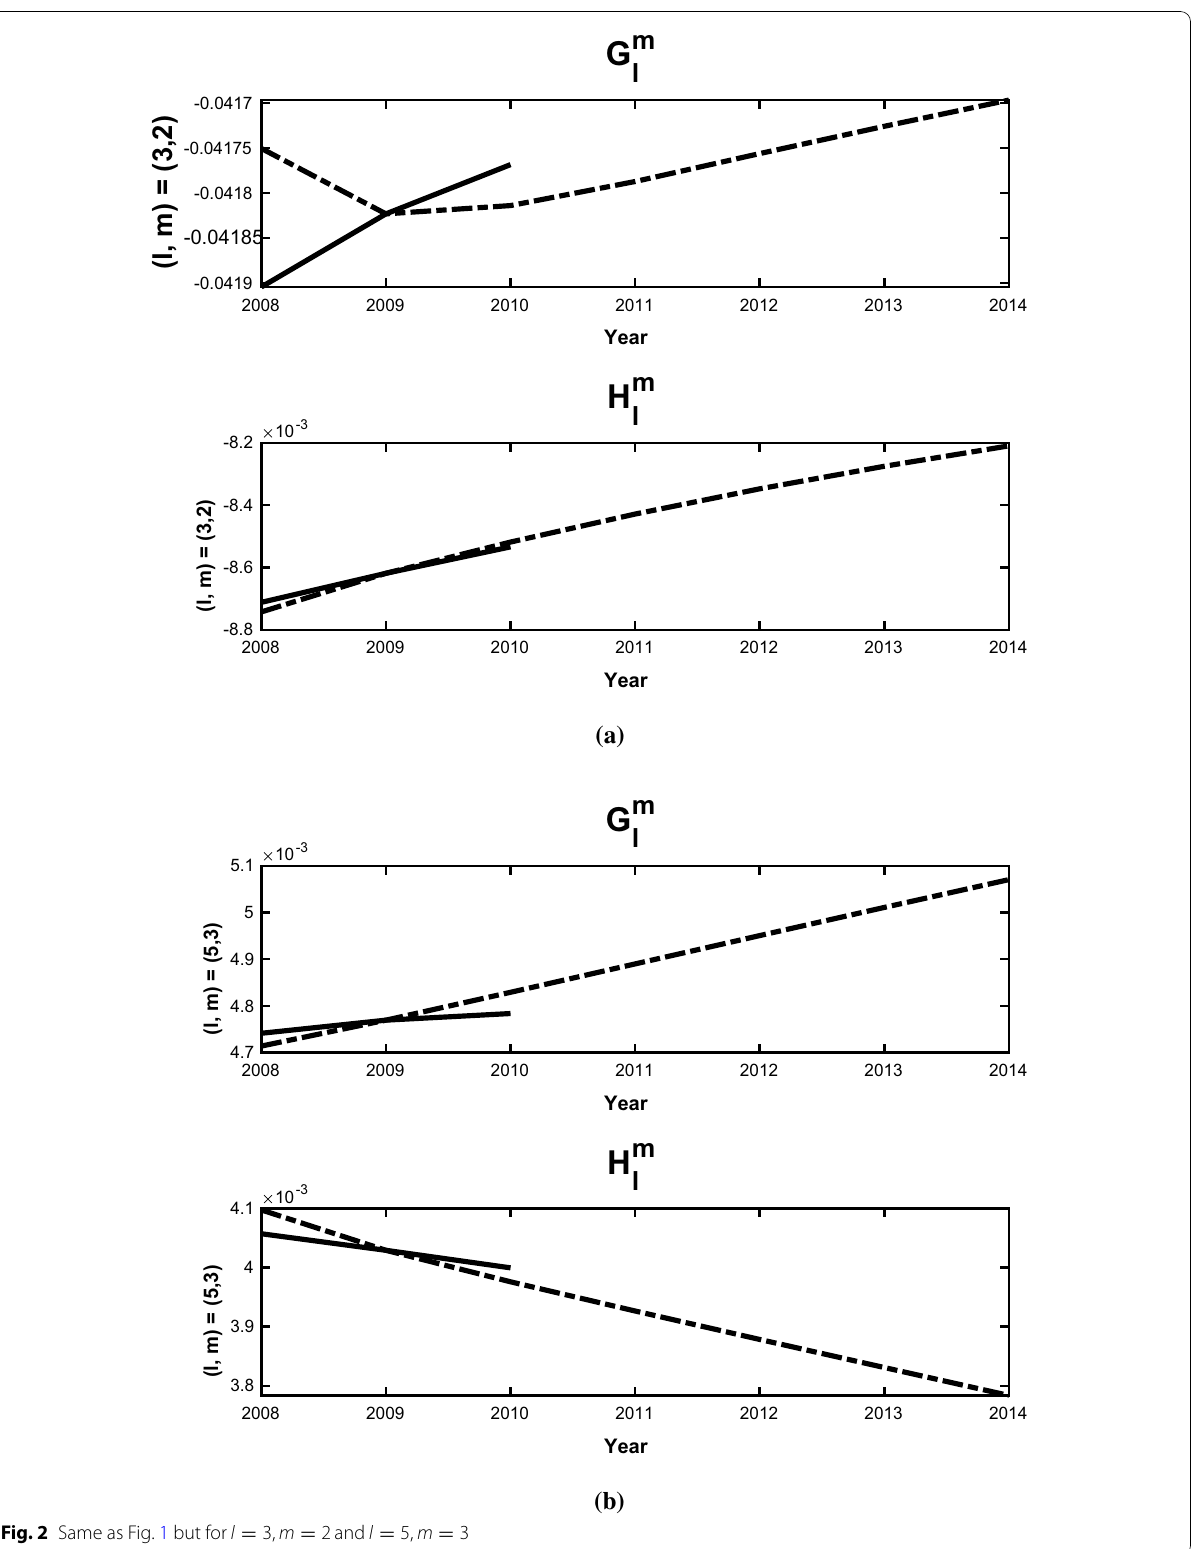
Fig. 2 Same as Fig. 1 but for l = 3, m = 2 and l = 5, m =